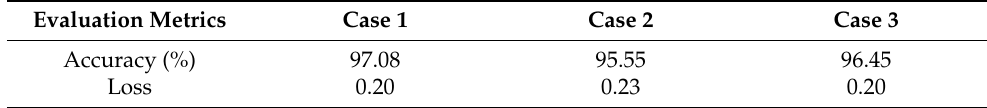
Table 2. Training accuracy and loss for each